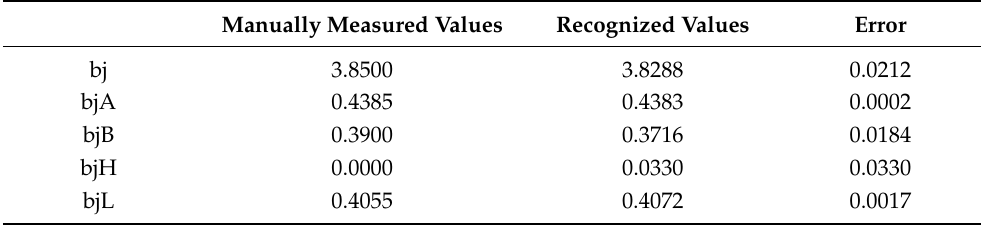
Table 5. Automated recognized results compared to manually read